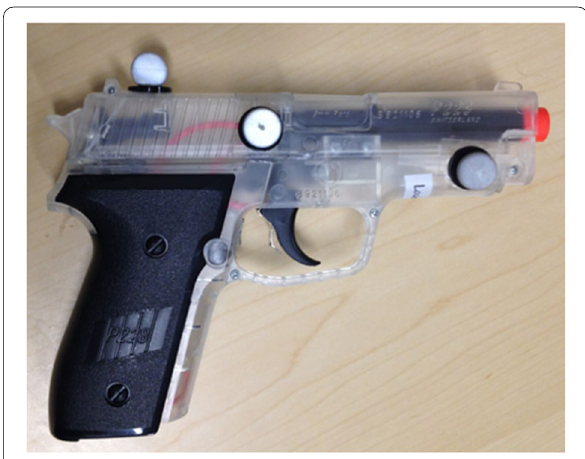
Fig. 13 Image of the gun used in the Experiment